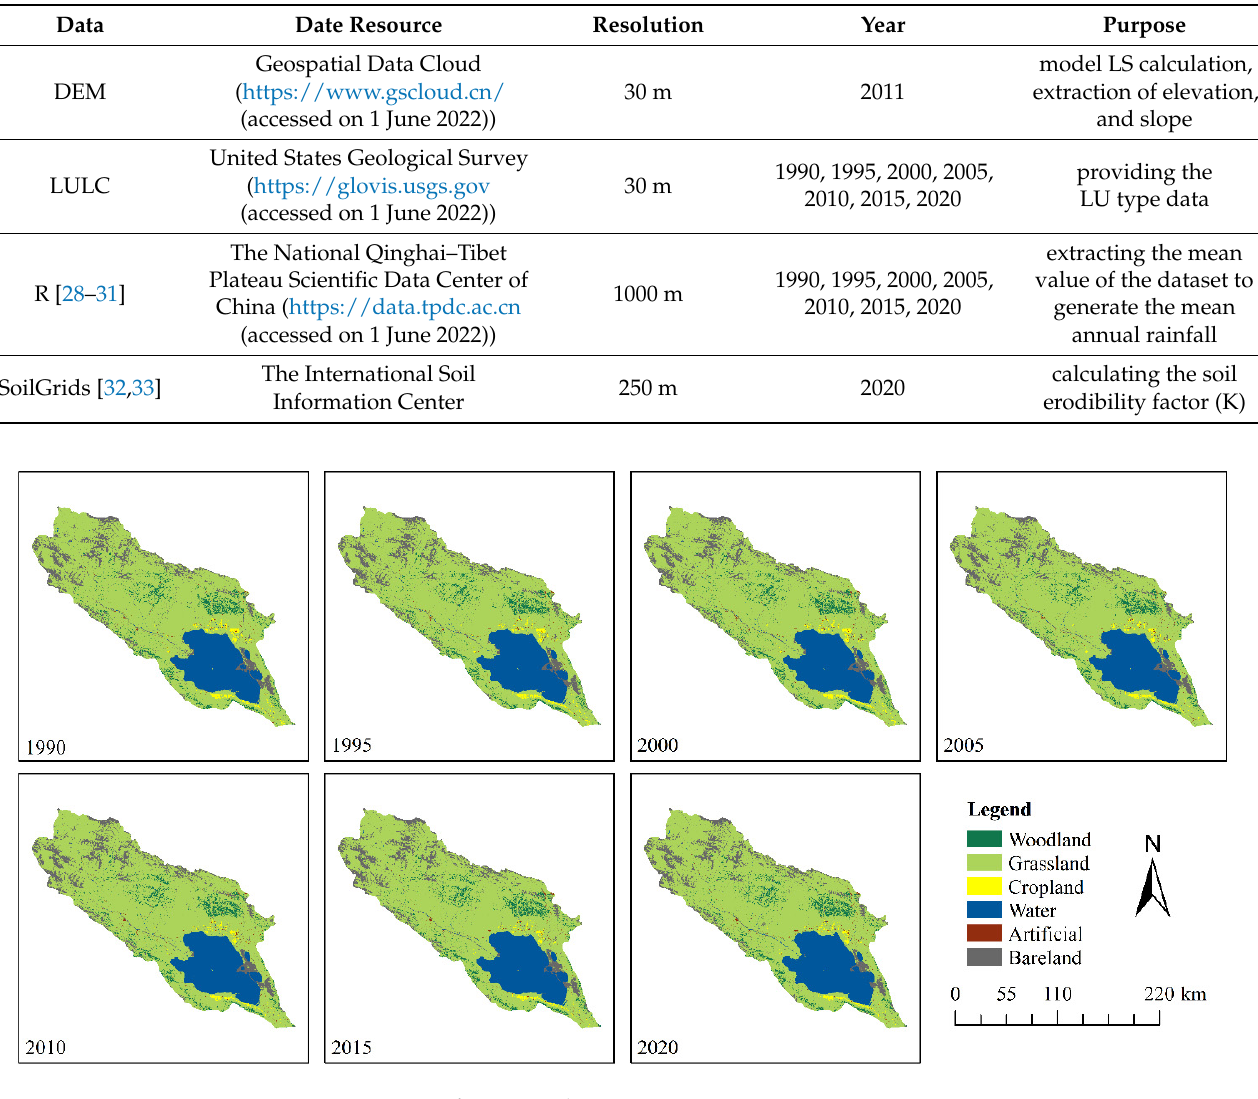
Figure 2. Map of LULC in the QLB.